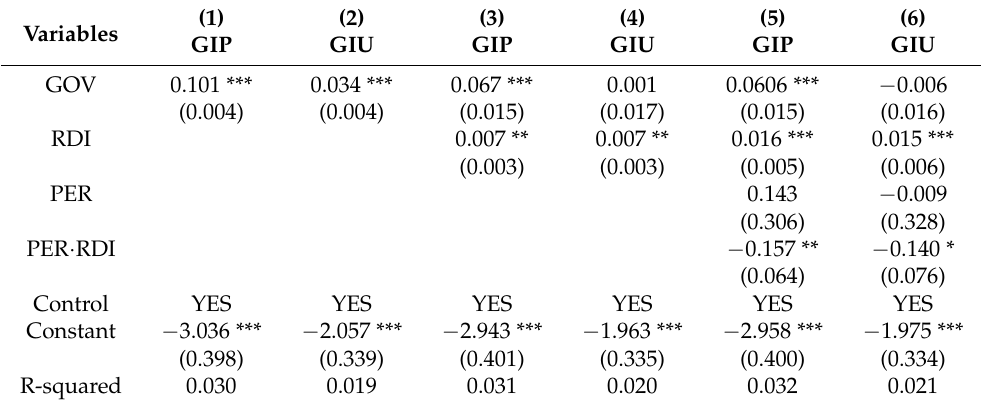
Table 5. Regression results based on green patents